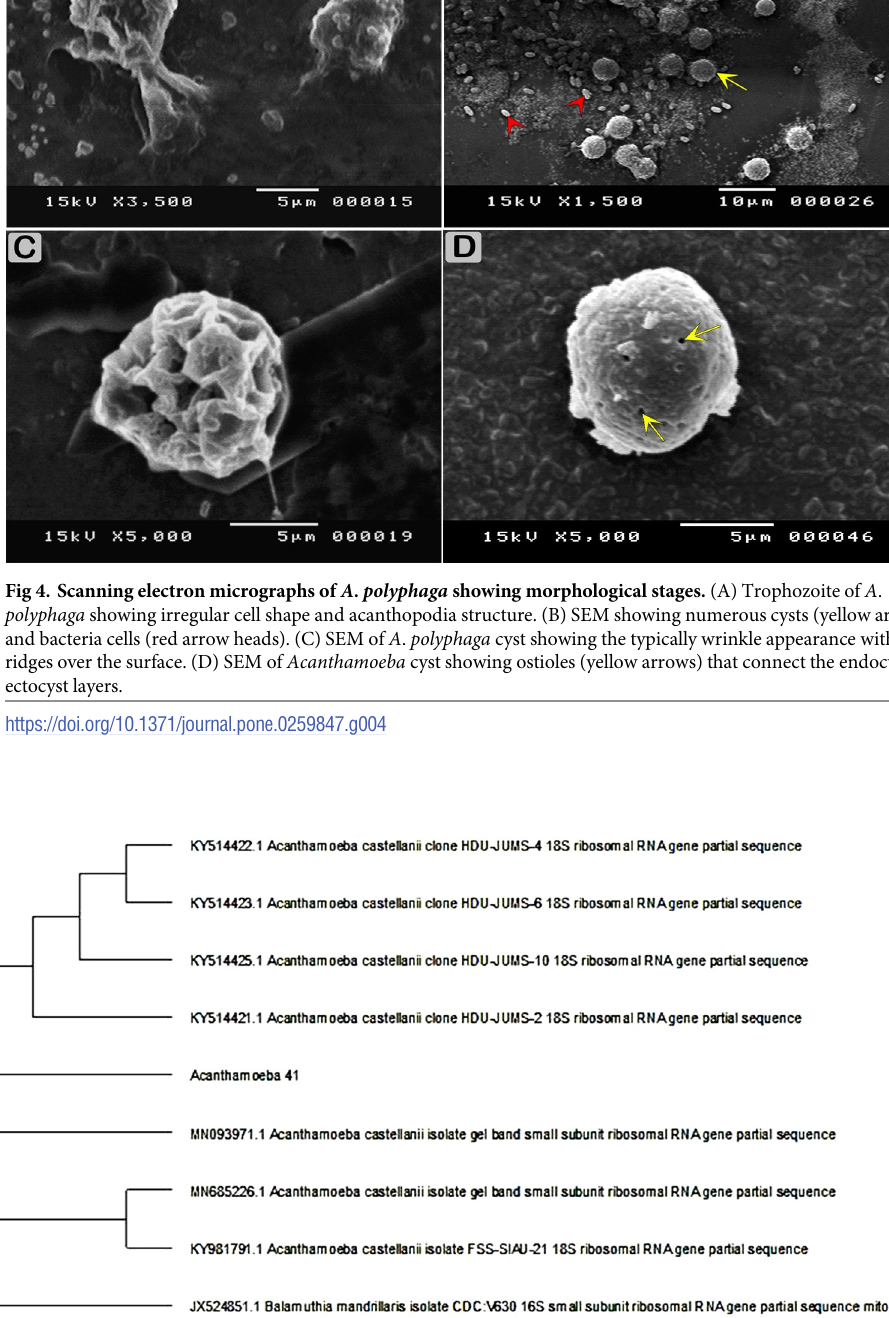
PLOS ONE | https://doi.org/10.1371/journal.pone.0259847 November15,